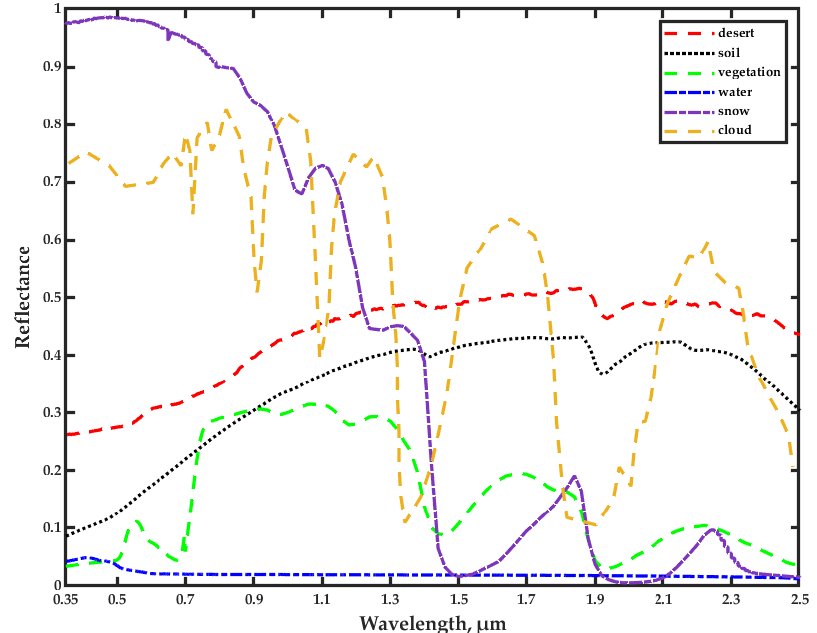
Figure 1. Reflectance curve of cloud and underlying surface. The underlying surface spectrum comes from ENVI spectral library [35], and the cloud spectrum comes from Airborne Visible Infrared Imaging Spectrometer.